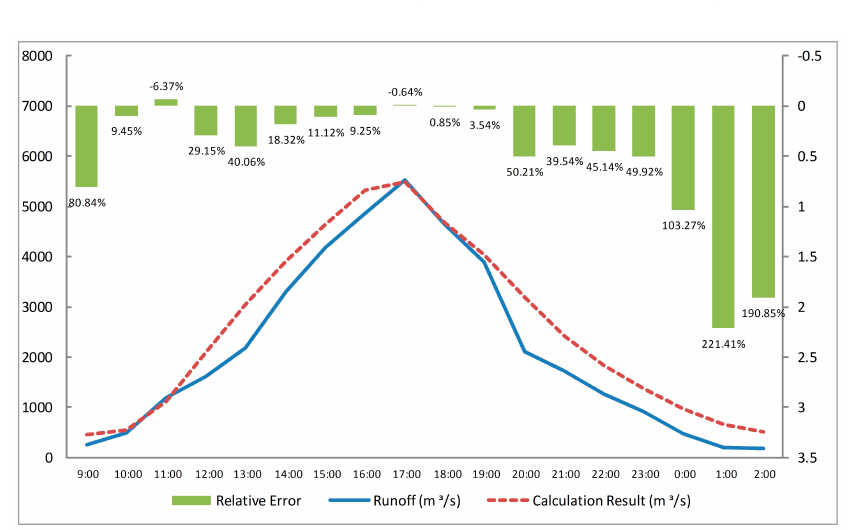
Figure 6. Xiangshui station coefficient test result.